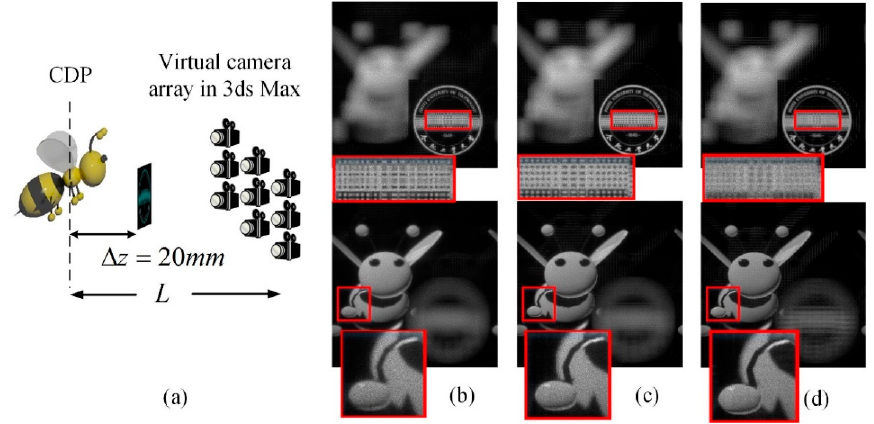
Figure 5. ( a ) A bee model and a school badge built in the 3 ds Max modeling software. The numerical reconstruction with capturing depth ( b ) L = 80 mm, ( c ) L = 45 mm, and ( d ) L = 30 mm.